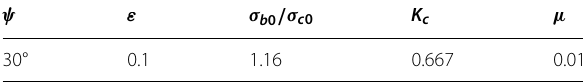
Table 1 Parameters of the CDP model for concrete.